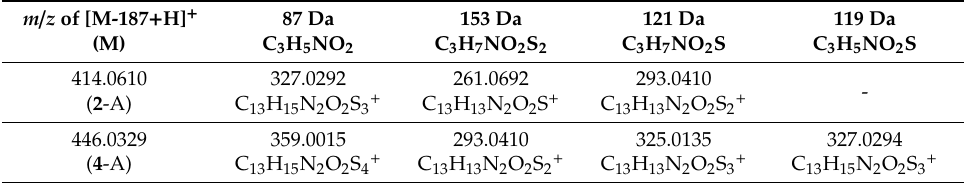
Table 9. Comparison of the most important NLs [X] and fragments [M-187-X + H] + of the main fragment of the A-labelled isomer of the derivatives 2 and 4